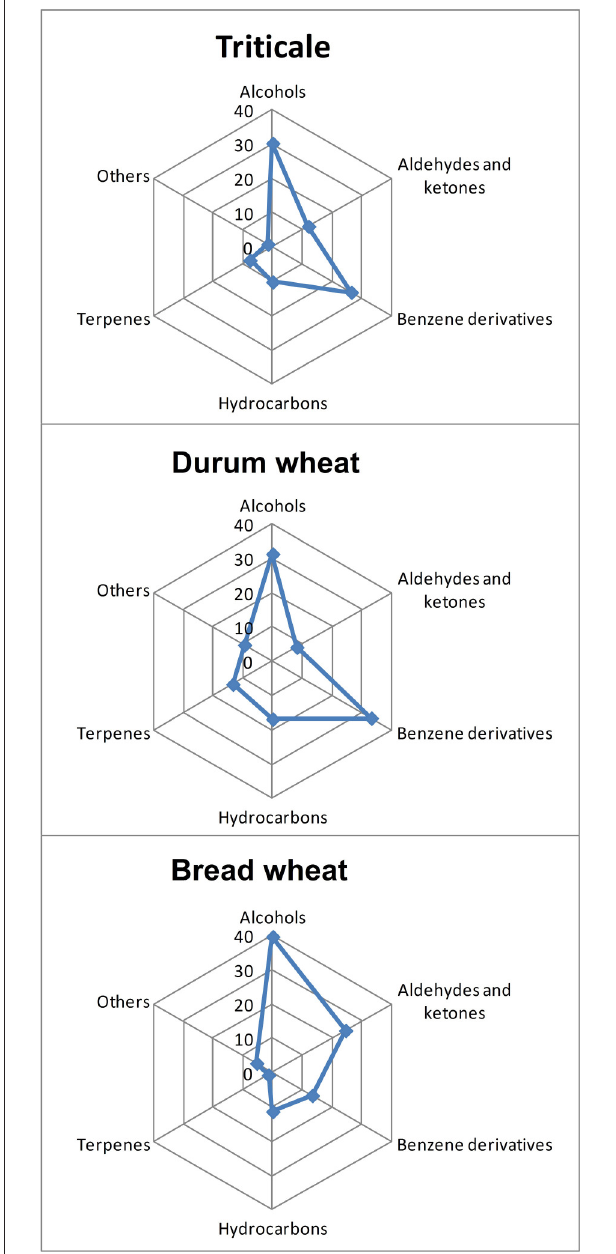
FIGURE 2 | Mean percentage contents of volatile compounds differentiating triticale, bread wheat, and durum wheat.